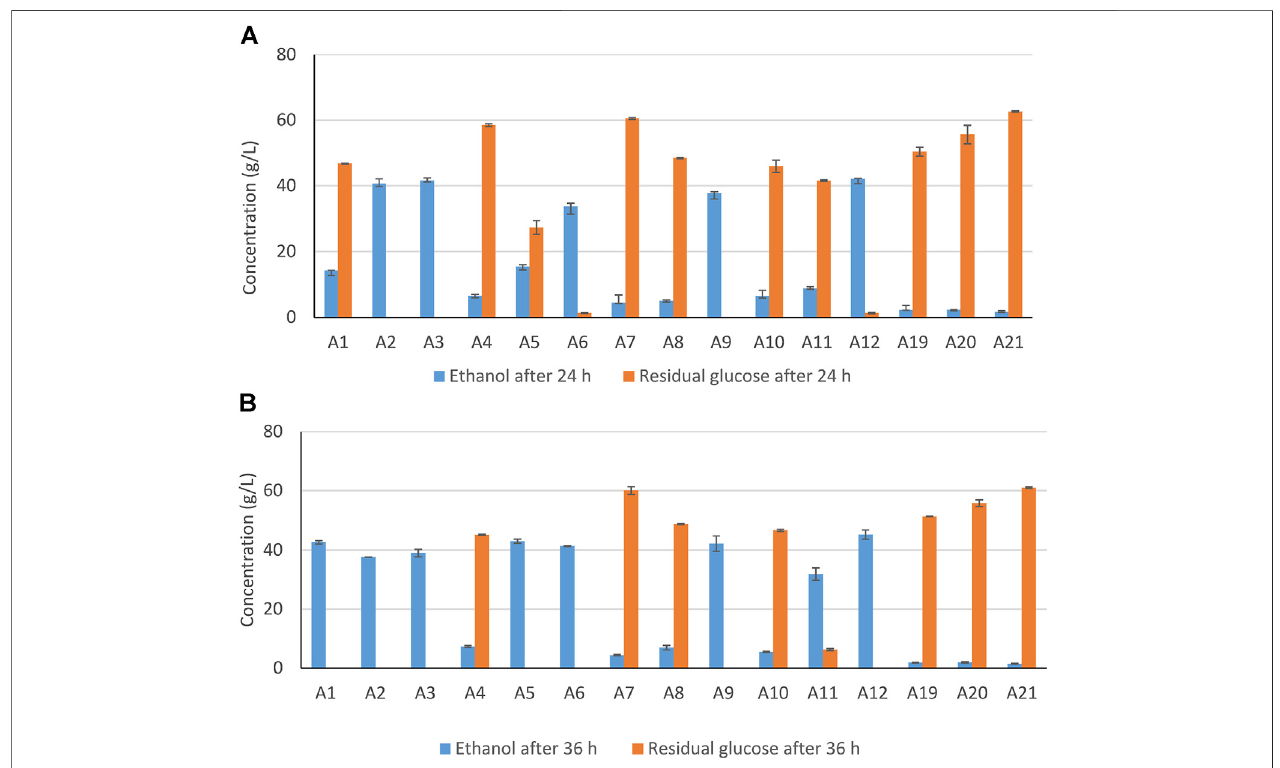
FIGURE 1 | Concentrations of ethanol and residual glucose after 24 h (A) and 36 h (B) of HHF of Norway spruce slurry with sodium sul fi te (A1 – A9), with sodium dithionite (A10 – A12), and without addition (A19 – A21). Error bars indicate standard deviations.